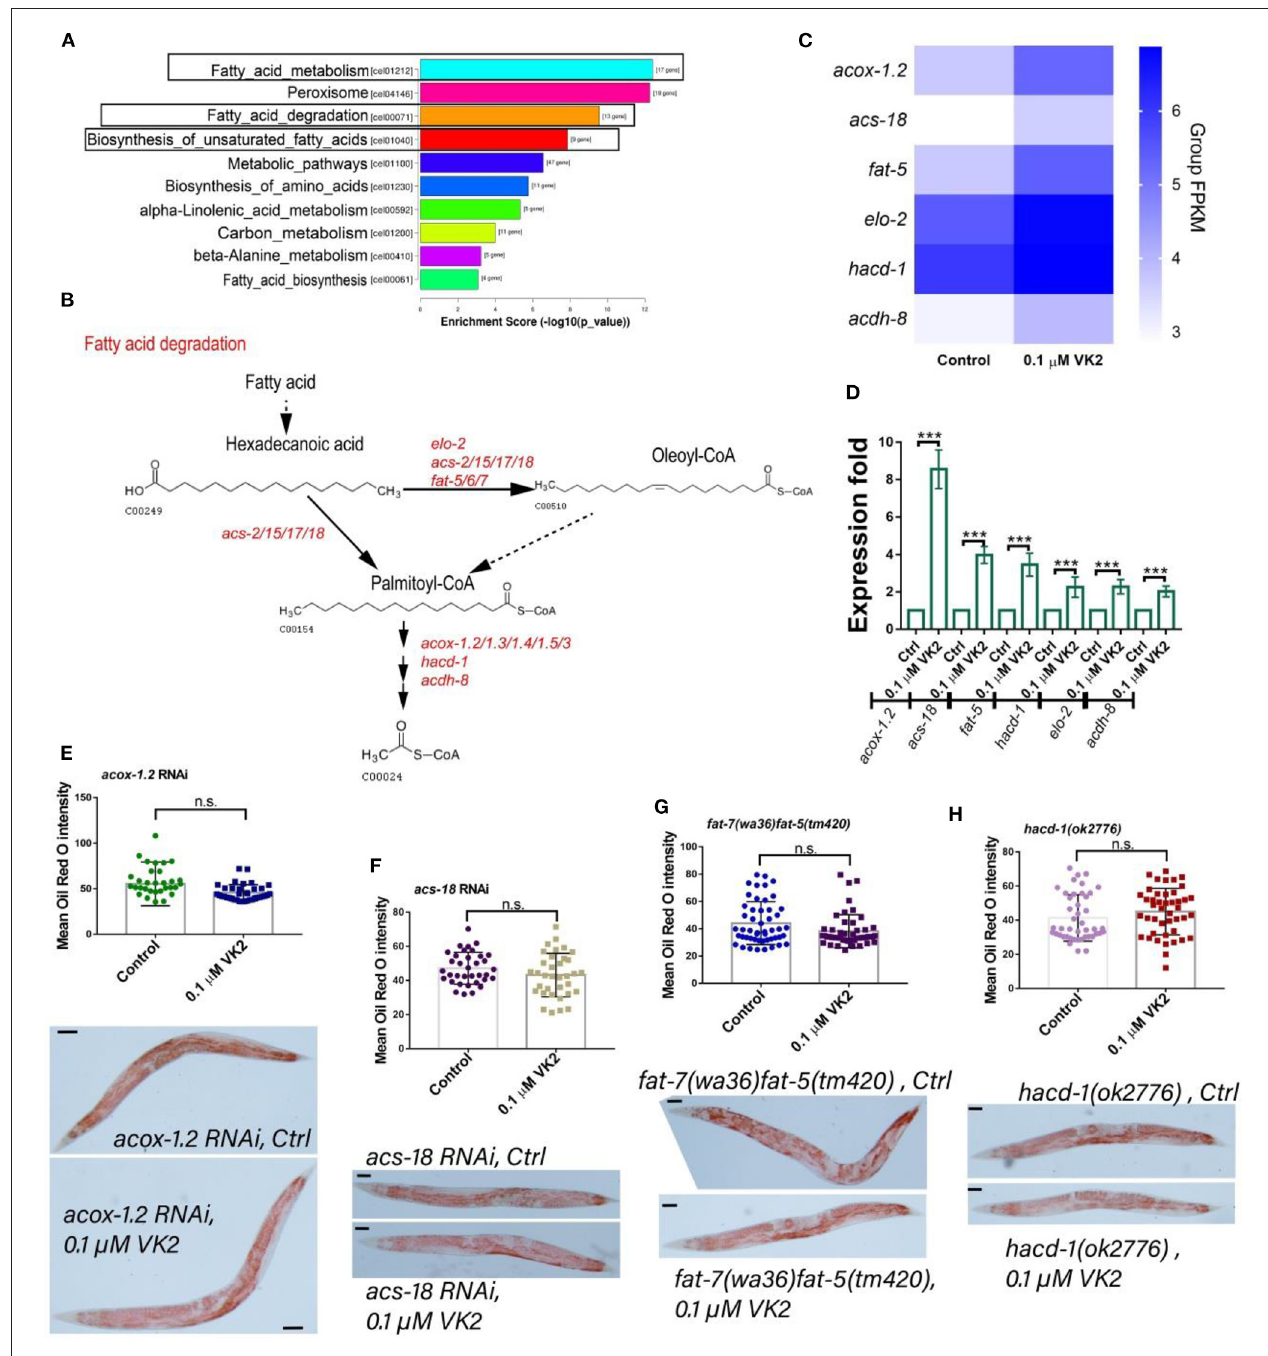
FIGURE 5 | VK2 enhances fat metabolism in worms. (A) The most significantly enriched KEGG pathways among the up-regulated genes induced by VK2 were fat metabolism-related pathways: fatty acid metabolism, fatty acid degradation, and biosynthesis of unsaturated fatty acid. (B) There were seventeen genes enriched among these pathways, and they each play important roles in these pathways, with their main functions summarized based on KEGG analysis. Fatty acids are elongated, desaturated, and added to CoA by these genes induced by VK2 and then degraded and digested via the process of fatty acid β -oxidation. (C) Heat-map analysis of these genes was carried out using Group FPKM based on RNA-seq data. (D) The expression levels of these 17 genes were further confirmed using real-time PCR. *** P < 0.001. Among them, acox-1.2 , acs-18 , fat-5 , and hacd-1 were the top four genes up-regulated by VK2 according to the real-time PCR data. The fat content reduction effects of VK2 were blocked by acox-1.2 RNAi (E) , acs-18 RNAi (F) , fat-5/7 (G) , or hacd-1 mutations (H) . The treatments were repeated at least three times, and the sample size was larger than 30 worms in each experiment. Scale bar: 50 µ M. The P -values were determined by using a t -test. n.s., no significant